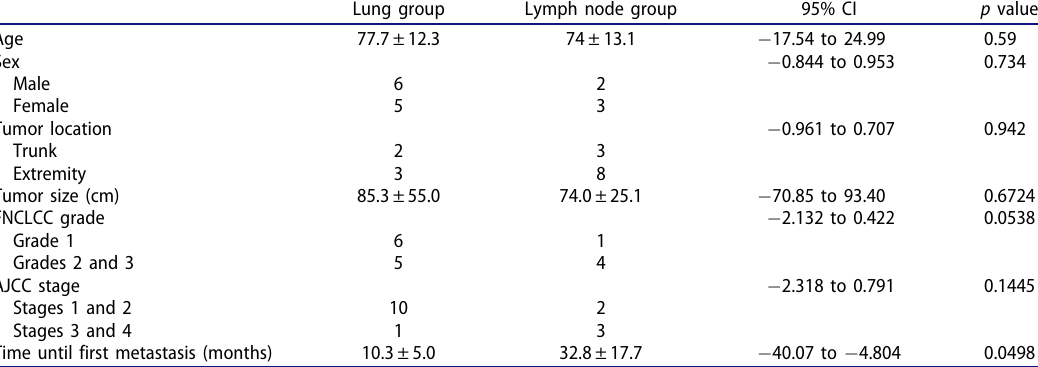
Table 2. Univariate logistic regression analysis between the two groups.